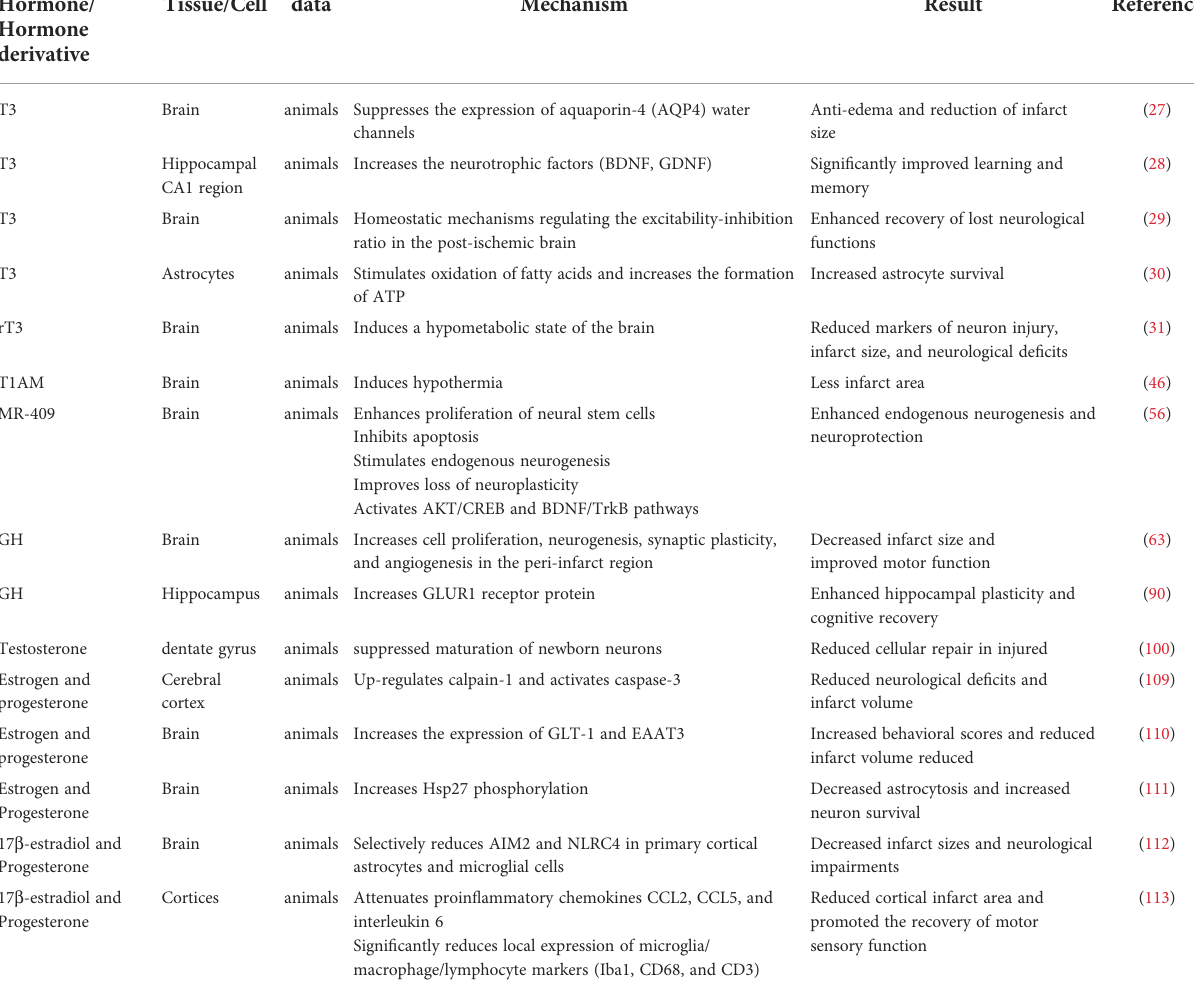
TABLE 2 Effects of hormones on ischemic stroke.